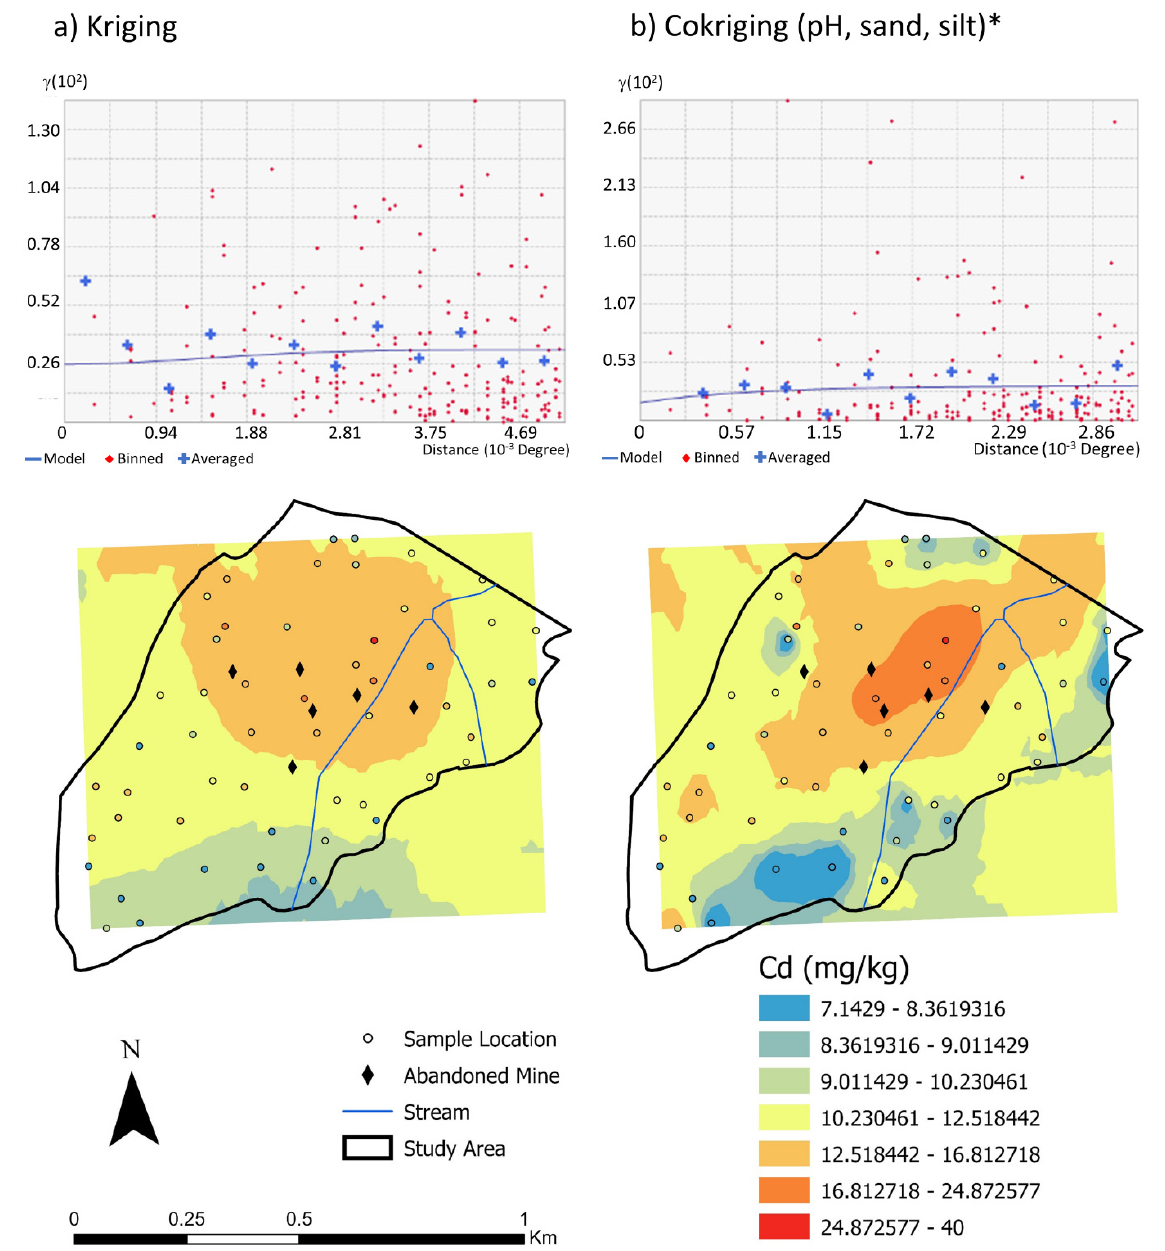
Figure 7. Variograms and interpolated Cd concentration using ordinary kriging ( a ) and cokriging ( b ). Cokriging model, marked with an asterisk, was selected as the superior model.